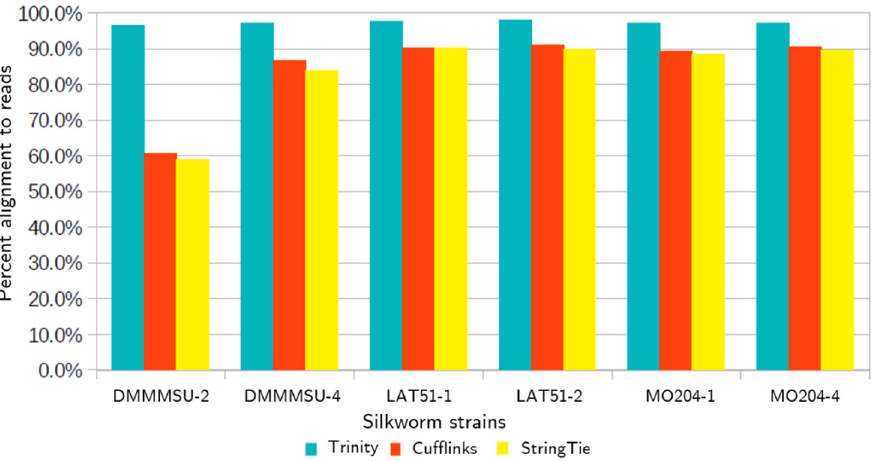
Figure 3. Overall alignment rate of RNA-seq reads to the transcriptome assemblies.